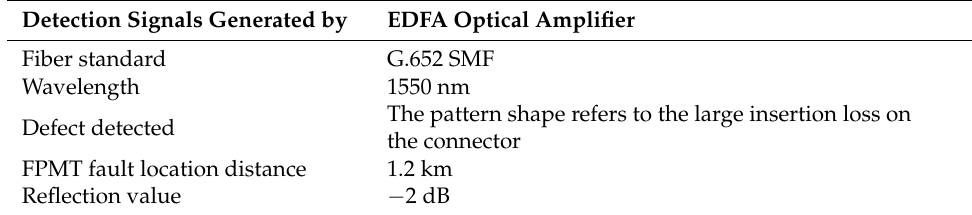
Table 8. The parameters and practical results detected at event 4.